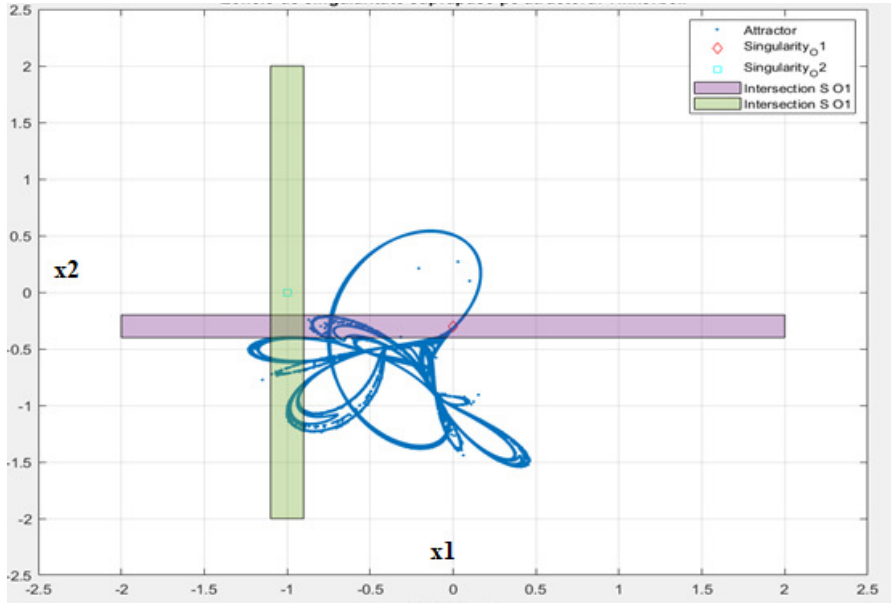
Figure 6. Singularity areas for the Tinkerbell system.